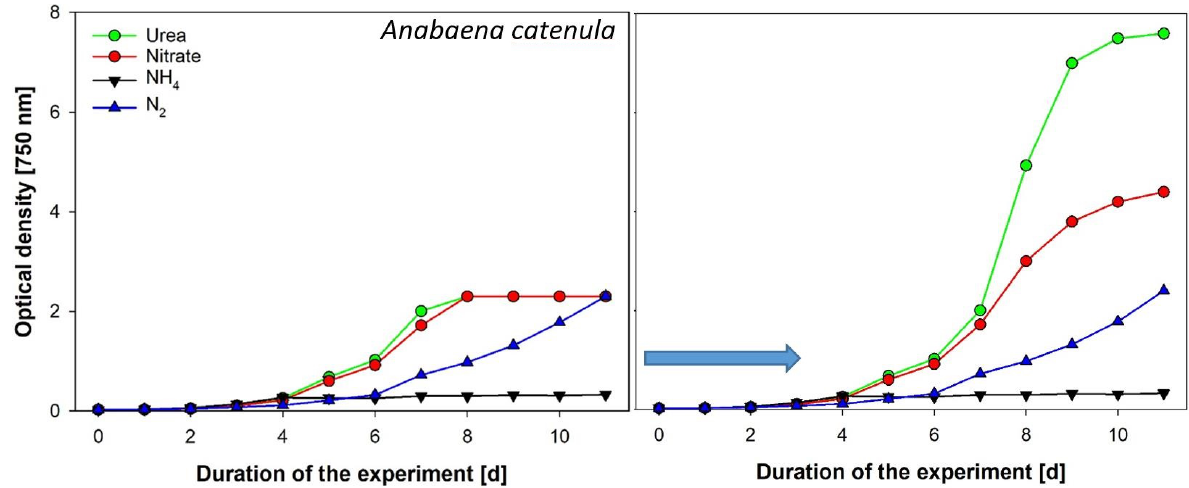
Figure 6. Growth experiment with the cyanobacterium Anabaena catenula supplied with different nitrogen sources (means of 3 replicates). Left : OD was measured without considering the upper absorbance limit of the spectrophotometer. Erroneous results are shown from which incorrect conclusions might be drawn. Right : samples were diluted at absorbance values > 1 (indicated by the blue arrow) and then multiplied with the dilution factor.